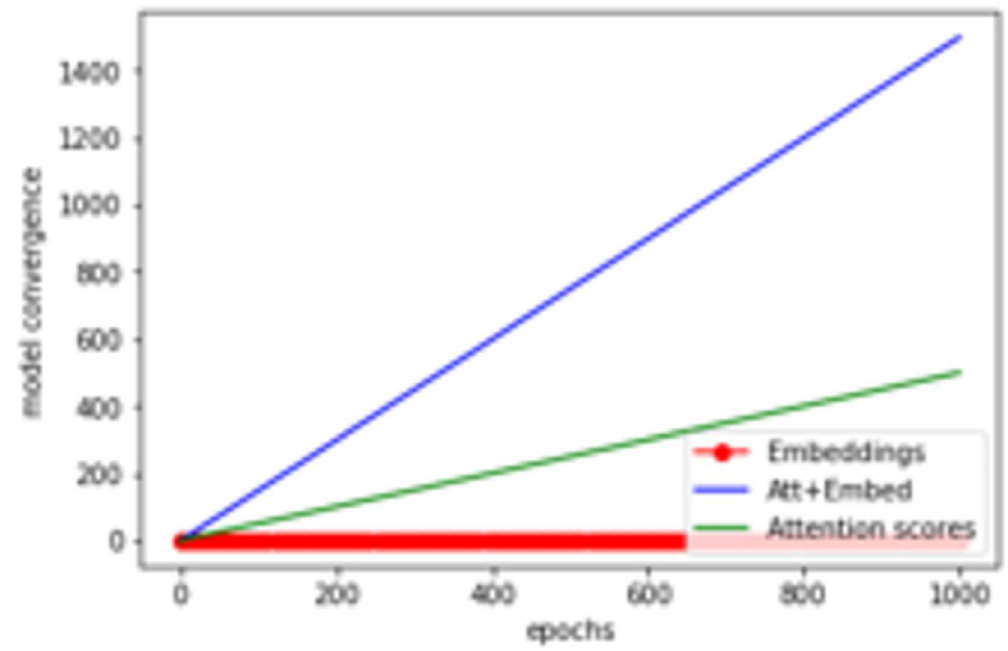
Fig 25. Impact of attention scores and embeddings on the model